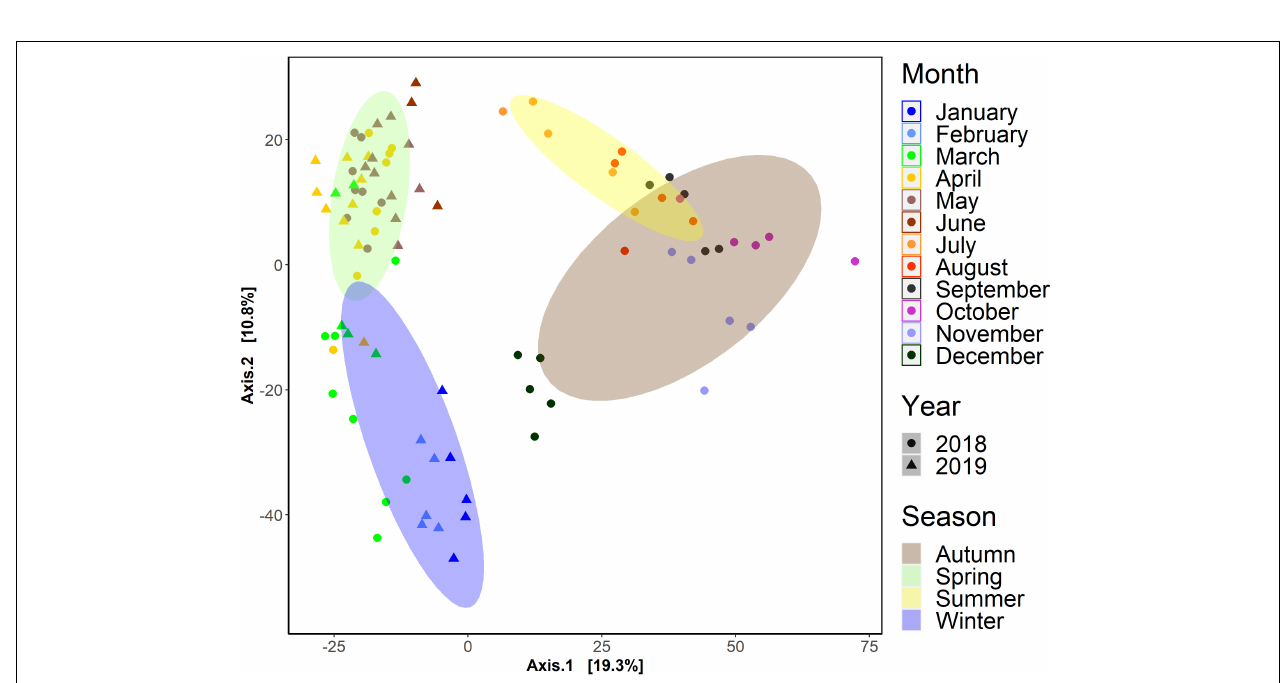
FIGURE 3 | Monthly, seasonally, and yearly arranged PCA ordination plot of all samples used for BCZ time-series. Results were obtained from clr transformed data (Aitchison distance) dissimilarity matrices calculated to explore entire community patterns in the time-series of the Belgian Coastal Zone. Statistical analysis showed significant differences among seasons (PERMANOVA, p <